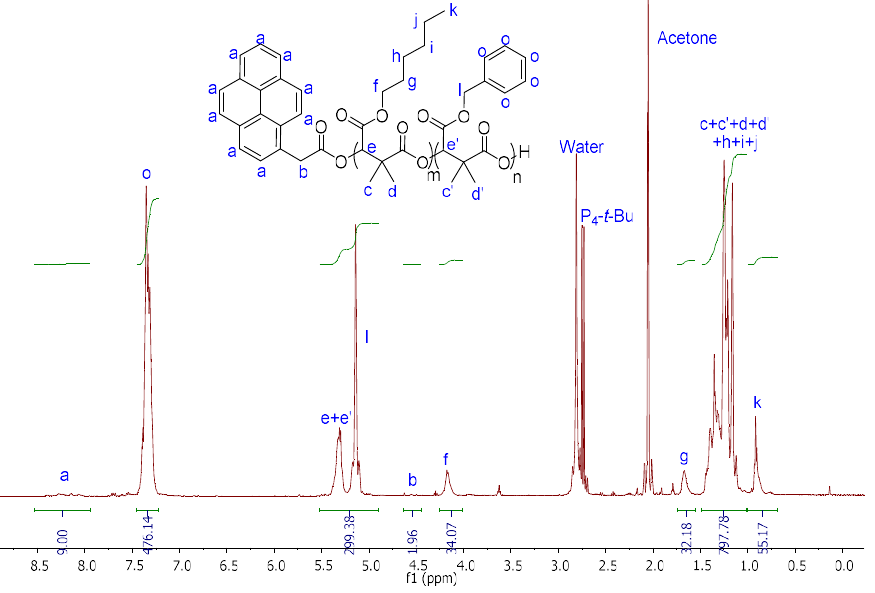
Figure 1. 1 H-NMR (500 MHz, Acetone-d 6 , 23 °C) spectrum of PdiMeMLABn 54 - b -PdiMeMLAHe 29 (Table 2, Entry 1).